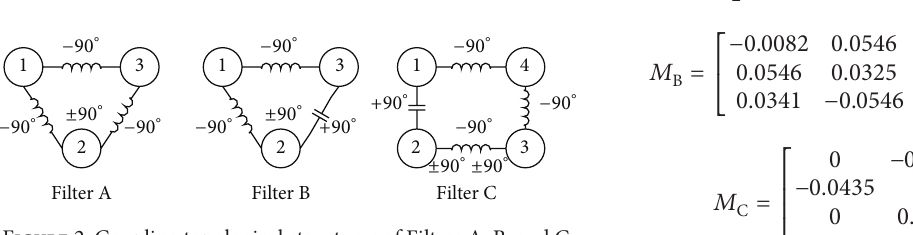
Figure 2: Coupling topological structures of Filters A, B, and C.